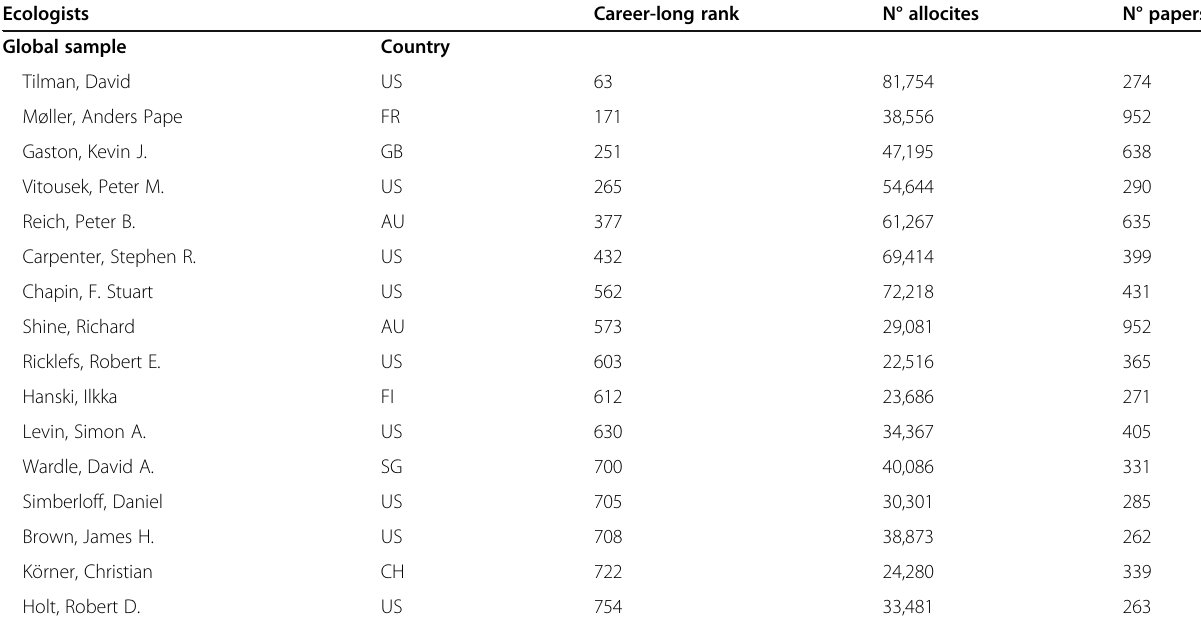
Table 1 Whole trajectory (Career-long) impact ranking of Latin American ecologists, No. allocites, and No. papers in the Scopus database, based on Table S-6, Career-long ranking, by Ioannidis et al. [3]. Here and elsewhere countries in decreasing order by total population size (Table 7). For the global sample, countries are identified by their ISO 3166 Codes (Continued) Ecologists Global sample